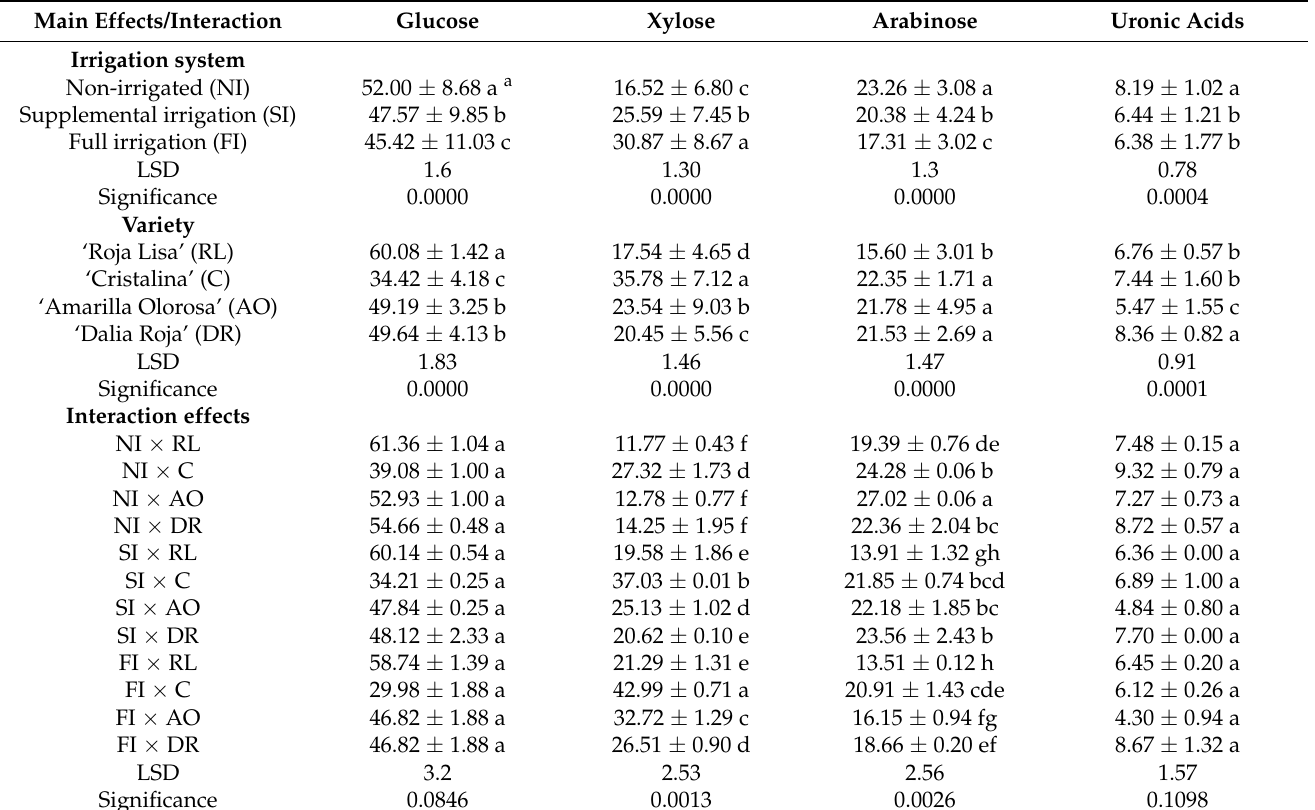
Table 4. Concentrations of sugars and uronic acids (% molar) in freeze-dried mucilage from cladodes of Opuntia varieties subjected to irrigation